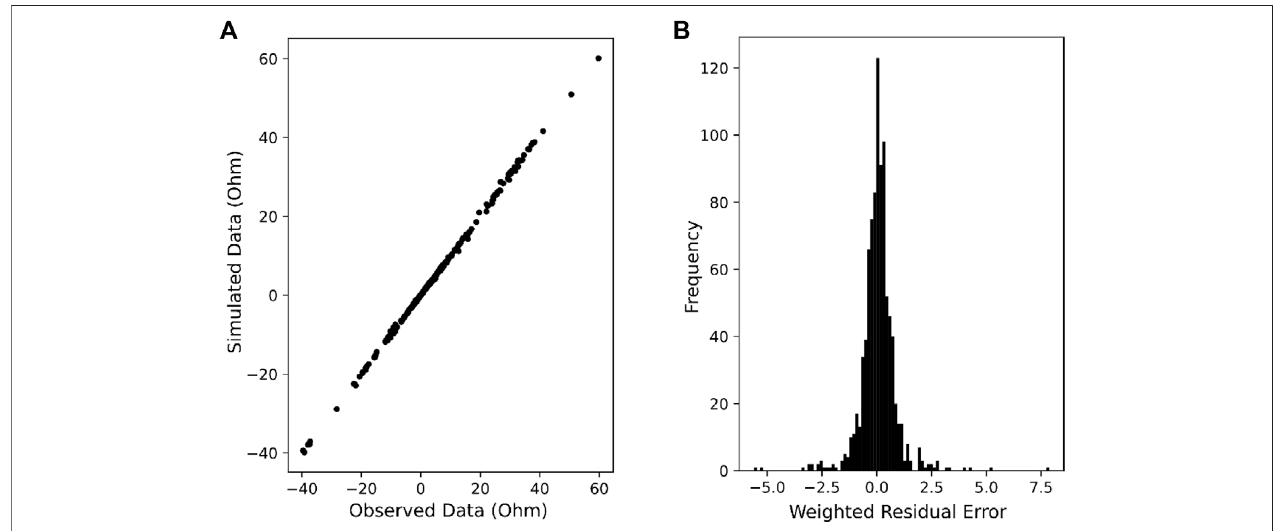
FIGURE 5 | Typical data fi t statistics for ERT inversions. (A) Simulated vs. observed ERT data at baseline inversion solution. (B) Weighted residual error histogram for baseline inversion.